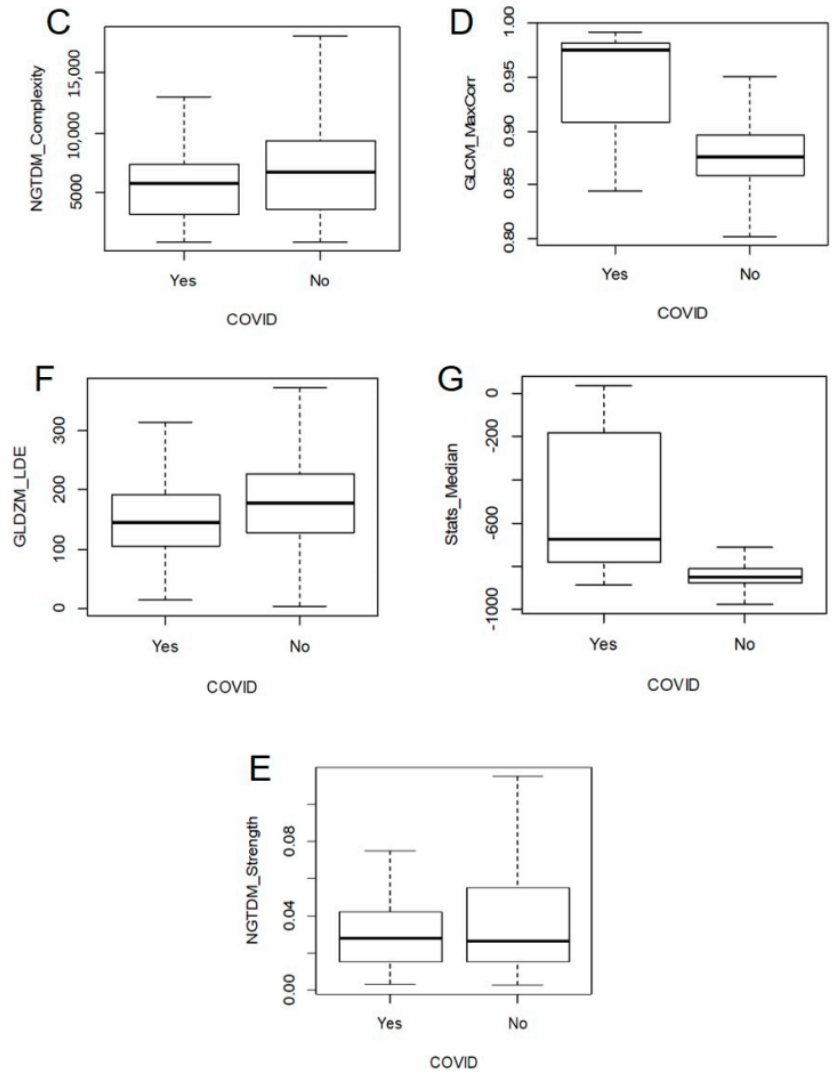
Figure 6. Chest CTs of a typical COVID-19 positive patient ( A ): original scan—left; heat-map—right) with evident reticulation, ground glass opacities and condensations compared to a healthy patient CT scan ( B ): original scan—left; heat-map—right). Heat-maps underline the more relevant areas for model prediction. Box plots comparing the distribution of the top 5 features among COVID and non-COVID cases (( C )—NGTDM_Complexity; ( D )—GLCM_MaxCorr; ( E )—NGTDM_Strenght; ( F )—GLDZM_LDE; ( G